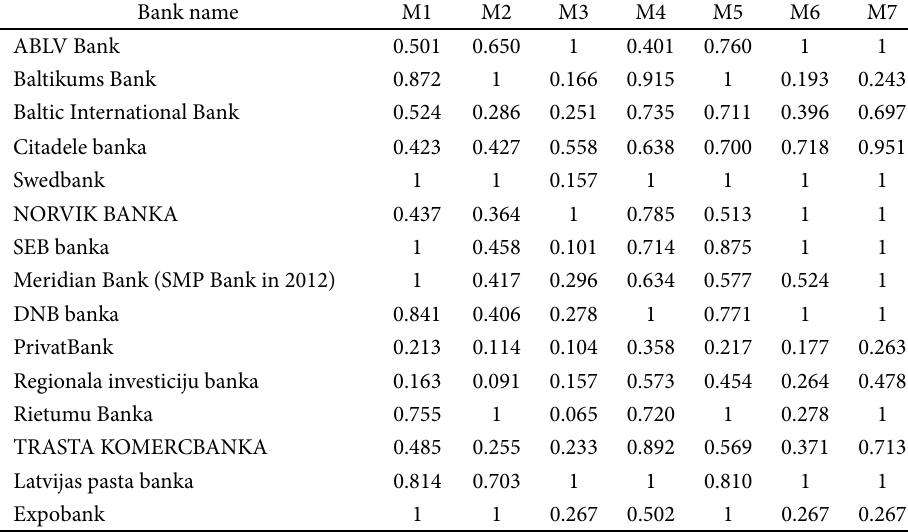
Table 6. Efficiency scores estimated for Latvian banks, using models M1-M7